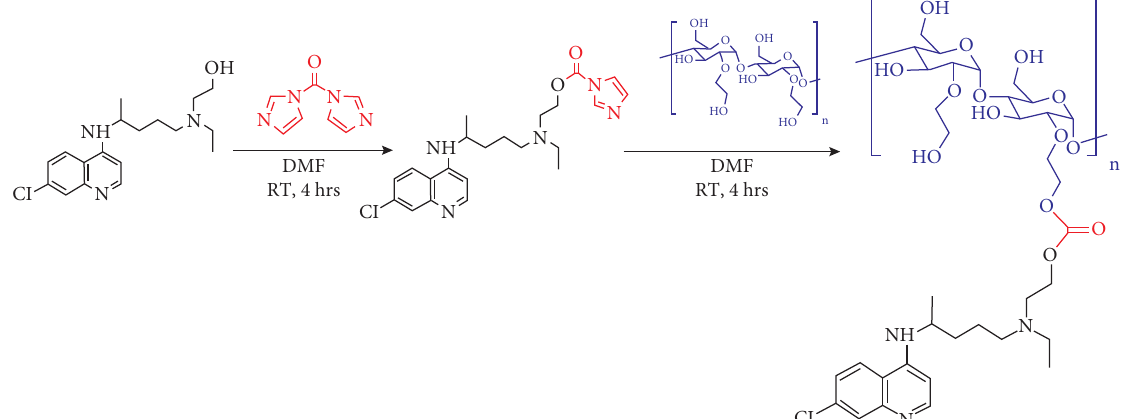
Figure 5: Molecular structure of